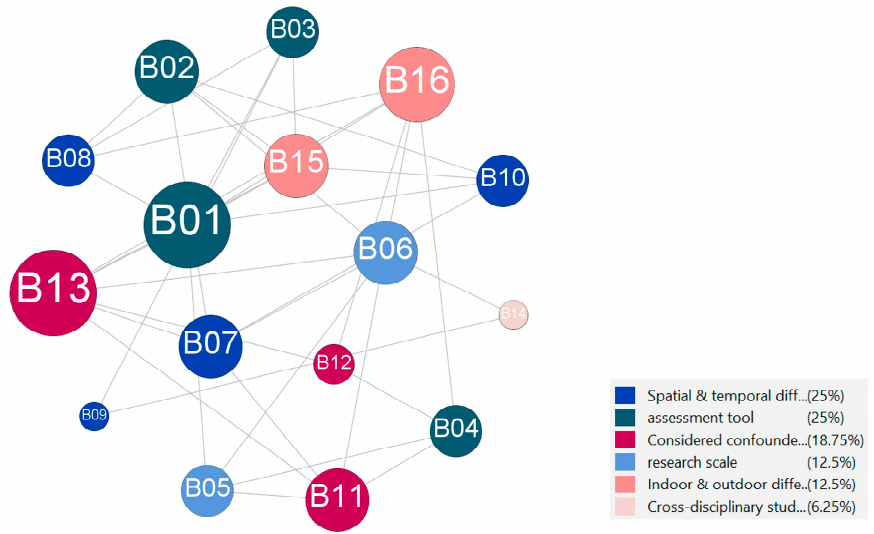
Figure 7. The Barriers Network Model.